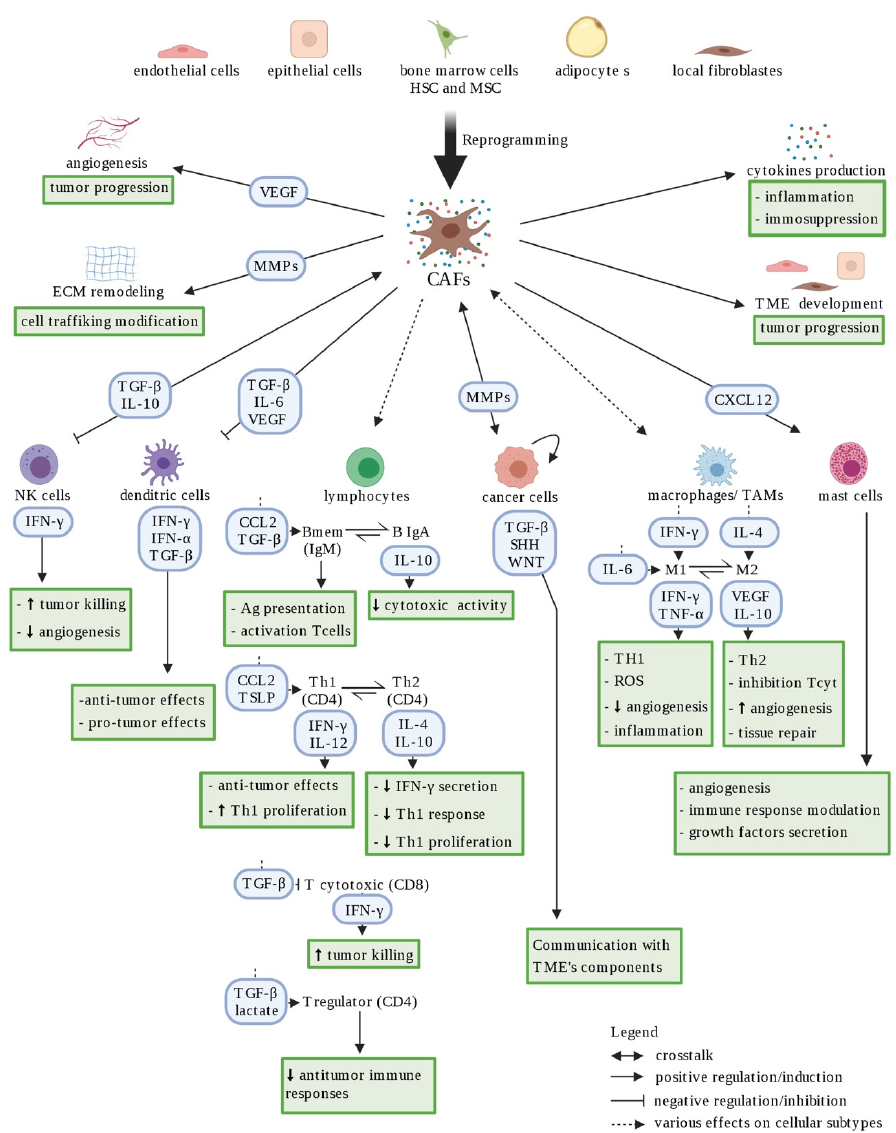
Figure 3. Schematic representation of CAF heterogeneity. Cancer-associated fibroblasts (CAFs) represent a heterogeneous cellular population within the tumor microenvironment, originating from various sources (i.e., epithelial cells, endothelial cells, quiescent fibroblasts, ...). CAFs shape the immune microenvironment in tumors toward a pro-tumorigenic and immunosuppressive milieu by affecting the recruitment and function of various innate and adaptive immune cells. Red arrows represent negative regulation/inhibition and blue arrows represent positive regulation/induction. Doted arrows represent a neutral effect. Created with BioRender.com (accessed on 4 January